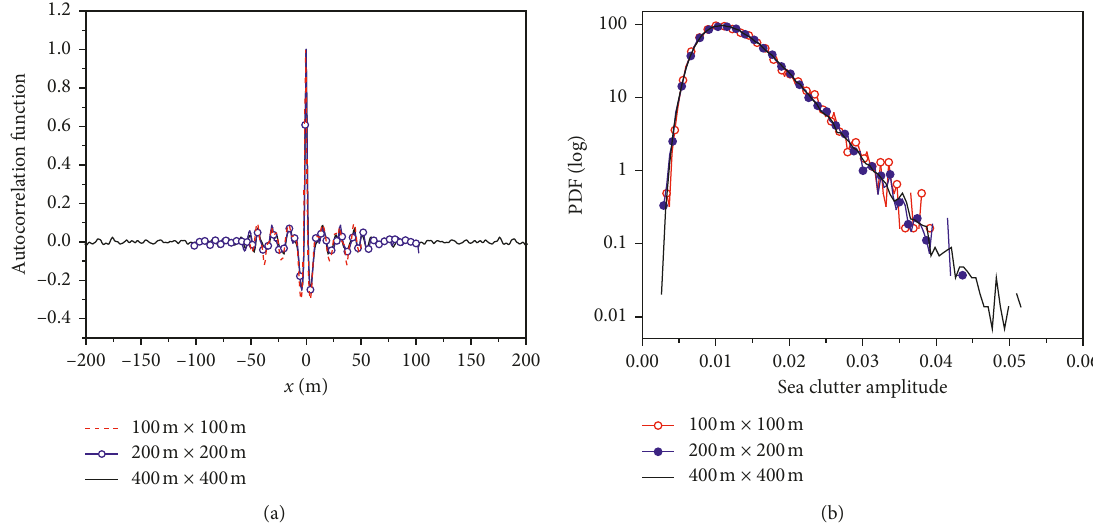
Figure 5: Comparisons of 1D plot of the autocorrelation function and PDF of 2D sea clutter by the statistical model with different sizes of scenes. (a) 1D plot of the autocorrelation function. (b) PDF. Table 1: Comparison of the consumed time in the simulations of 2D sea clutter with different sizes of scenes. The size of scene (m 2